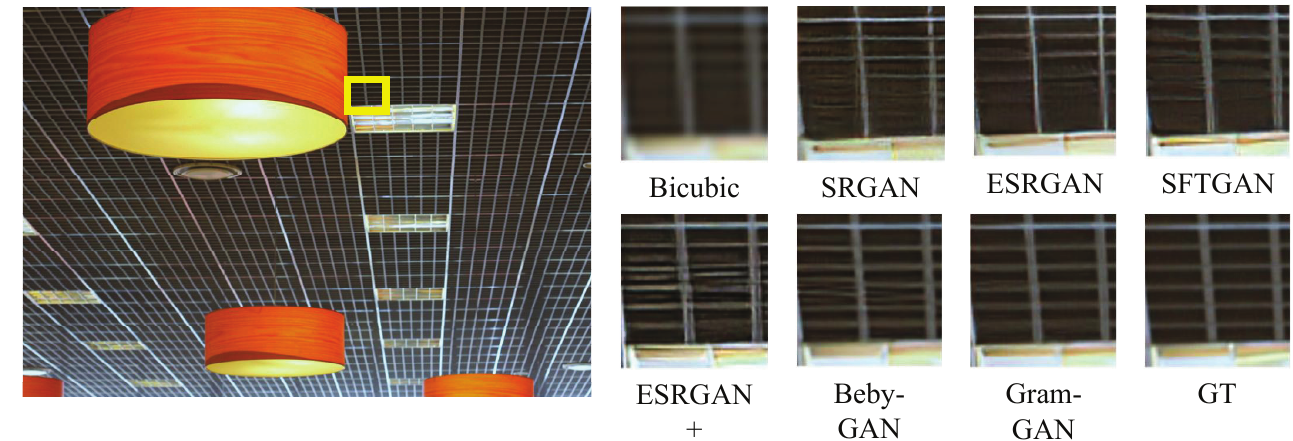
Figure 6. Visual evaluation of state-of-the-art perception-driven methods. Image “img_044” from Urban100.